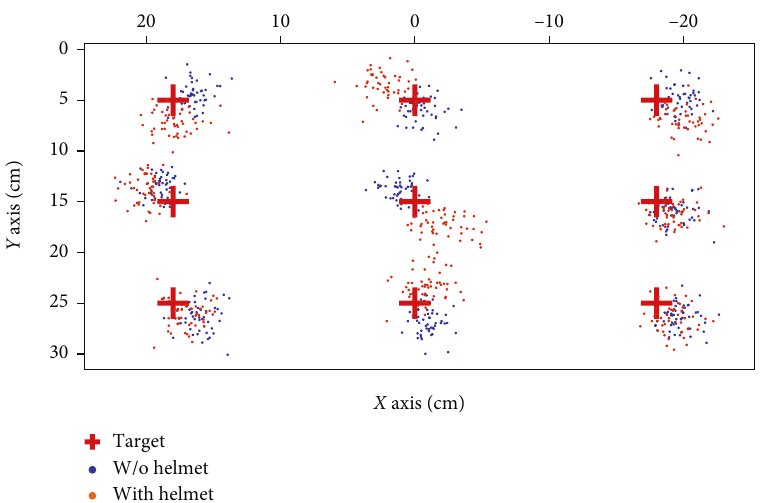
Figure 11: Visualized results of gaze marker landing estimation with subjects at 60cm away from the screen.